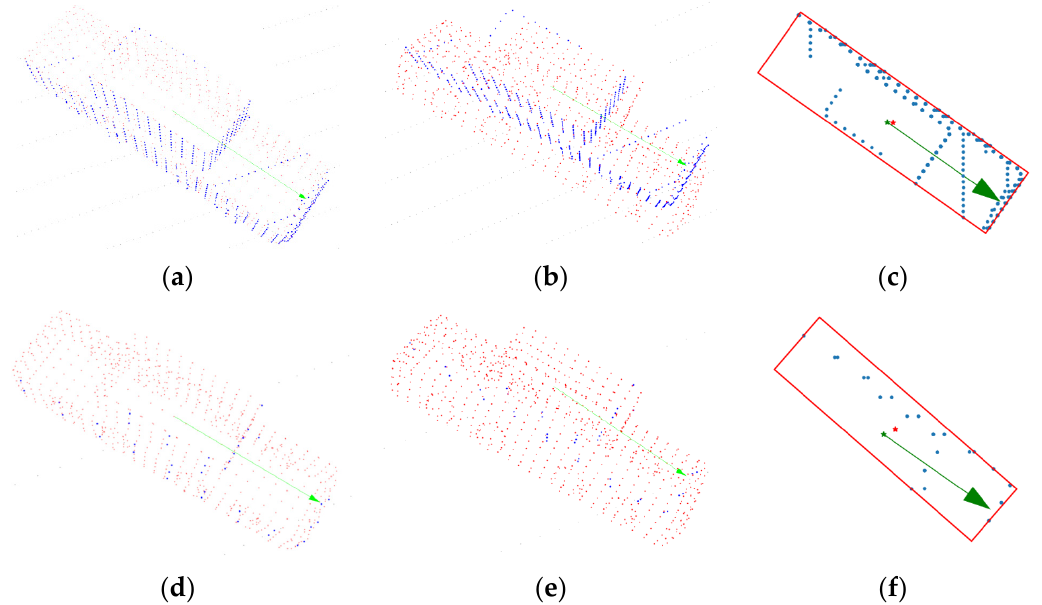
Figure 10. Typical pose estimation results of different methods, where blue points represent the measurement data and red points represent the estimated pose results. Green arrows represent the ground truth (arrow starting point represents the ground truth location, and the arrow direction represents ground truth orientation). ( a ) ECPC-ICP with S = 20; ( b ) PCA with S = 20; ( c ) L-fitting with S = 20; ( d ) ECPC-ICP with S = 2; ( e ) PCA with S = 2; ( f ) L-fitting with S = 2.